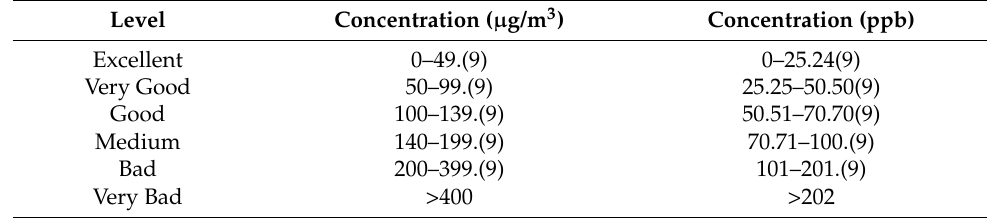
Table 2. NO 2 exposure limits.